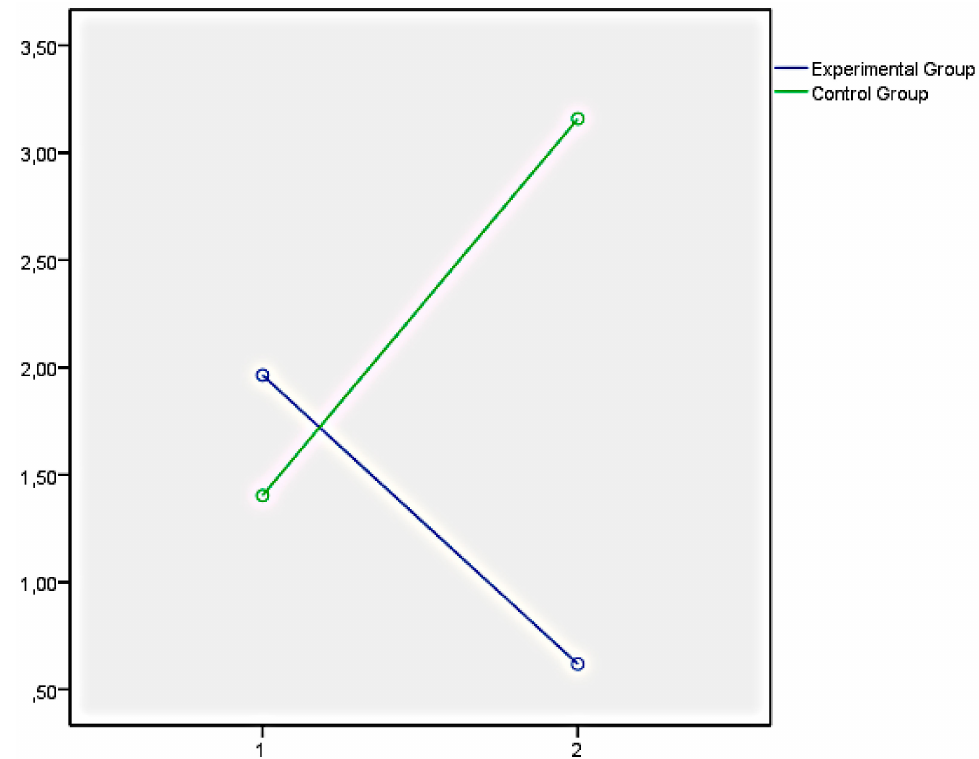
Figure 7. Criminal behaviour after the educational intervention measured with the Antisocial-Criminal Behaviour